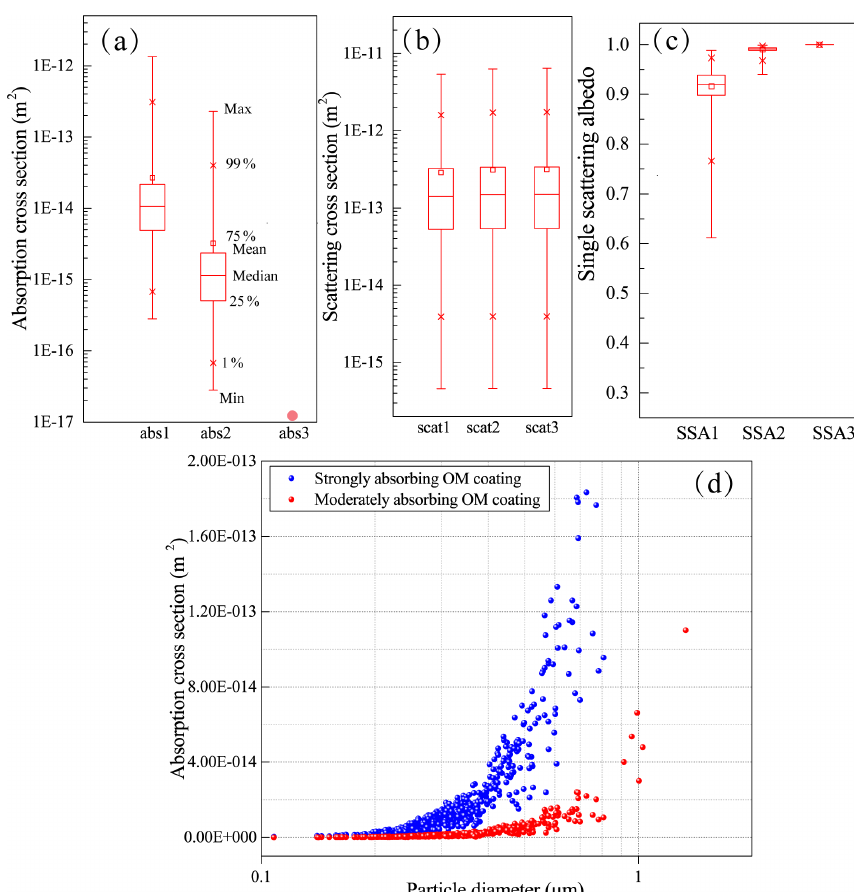
Figure 8. Optical properties of box-and-whisker plots showing optical parameters of all analyzed particles assuming sulfate core and BrC shell (not considering soot cores in the particles). (a) Scattering cross section. (b) Absorption cross section. (c) Single scattering albedo. Top to bottom makers in the box-and-whisker represent max, 99%, 75%, mean, median, 25%, 1%, and min values. (d) Absorption cross section along with particle diameter assuming strongly absorbing BrC and moderately absorbing BrC as the particle OM coating. Abs1, abs2 and abs3 represent the BrC with highly, moderately and weakly absorbing